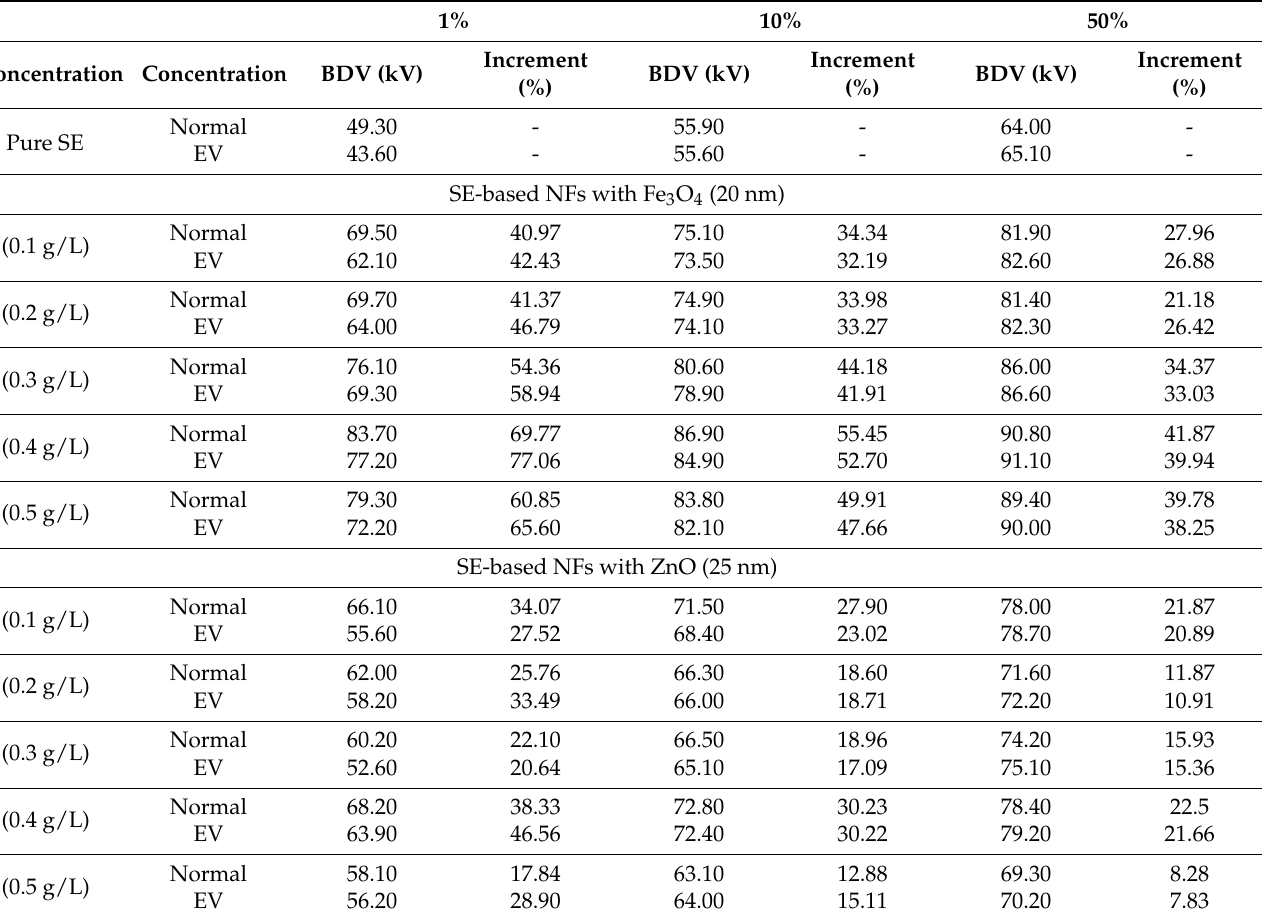
Table 5. The AC BDV at 1, 10, and 50% probability levels evaluated from normal and extreme value fit curves.